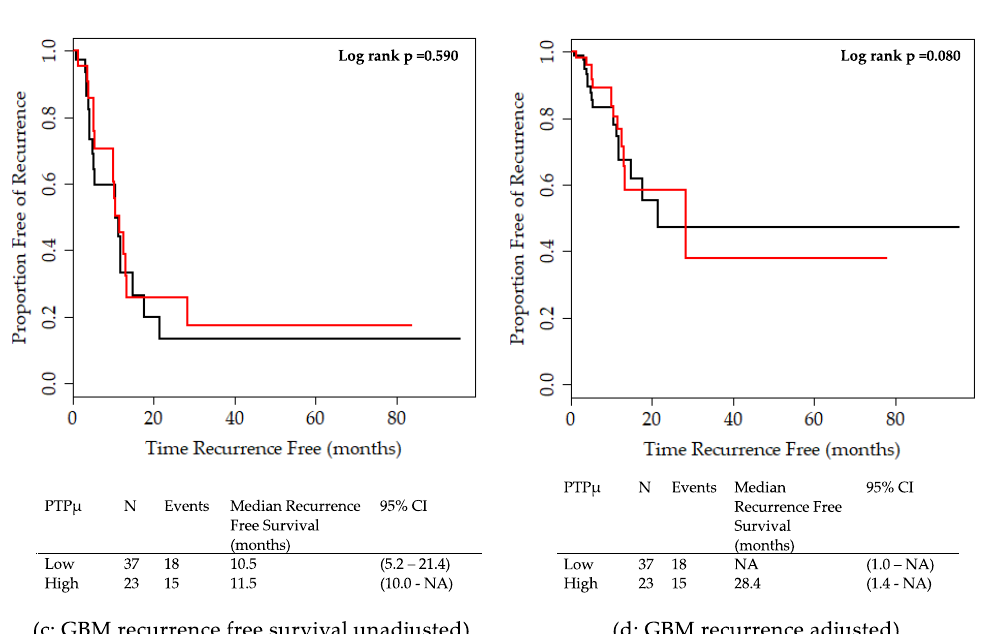
Figure 5. Kaplan Meier survival plots for overall survival and recurrence-free survival by PTPµ high versus PTPµ low staining for GBM patients only. ( a ) Unadjusted overall survival for GBM patients. ( b ) Overall survival adjusted for sex, age group, and IDH1 mutation for GBM patients. ( c ) Unadjusted recurrence-free survival for GBM patients. ( d ) Overall recurrence-free survival adjusted for sex, age group, and IDH1 mutation for GBM patients. Median overall survival or recurrence-free survival with 95% CIs are shown below each plot. Based on the log-rank test, recurrence-free survival curves were not significantly different between PTPµ high and low patients for either unadjusted or adjusted curves.